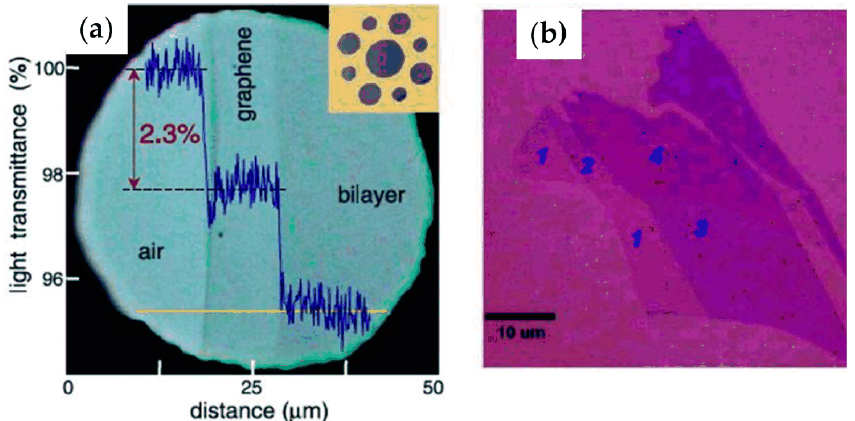
Figure 4. Optical transparency. ( a ) Light transmittance of monolayer and bilayer graphene and ( b ) optical image of graphene flakes with one, two, three, and four layers on a 285-nm thick SiO 2 -on-Si substrate [47].